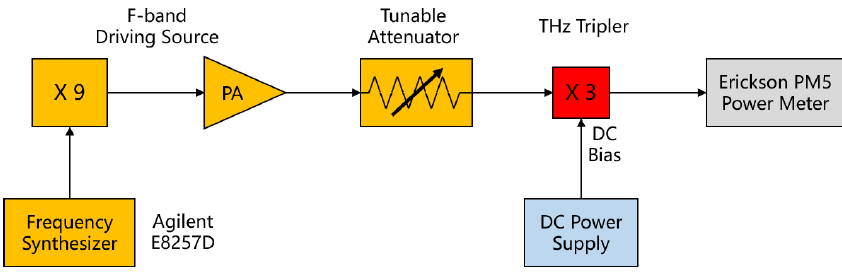
Figure 11. Schematic diagram of the 0.34 THz tripler’s output power test setup.